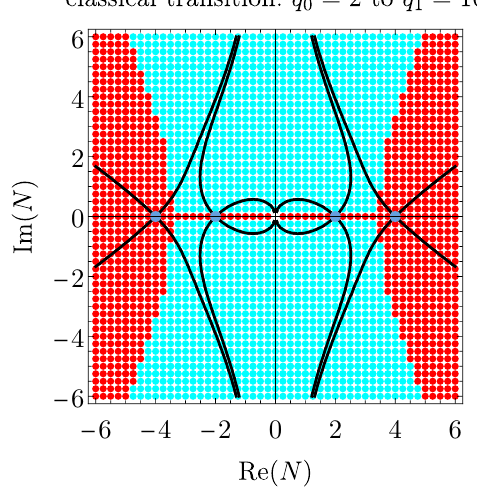
Figure 8 . Complex lapse plane for the classical transition from a small scale factor, q 0 = 2 , to a larger scale factor, q 1 = 10 , with Λ = 3 . Saddle points (at N SP = ± 2 , ± 4 ) are in blue, and contours of steepest ascent and descent are in black. The inner saddle points, corresponding to expanding solutions, are reachable via allowable complex metrics (in cyan), while the outer saddle points, corresponding to classical bouncing solutions, appear not to be reachable as they are surrounded by red — non-allowable — points. However, as argued in the core text, this is most likely an artifact of our metric ansatz, which proves to be too restrictive in the present